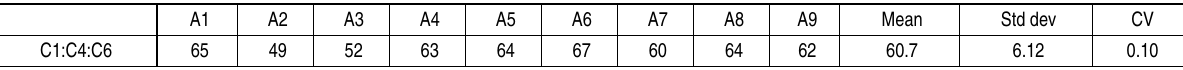
Table 47. Consortium C1:C4:C6 performance